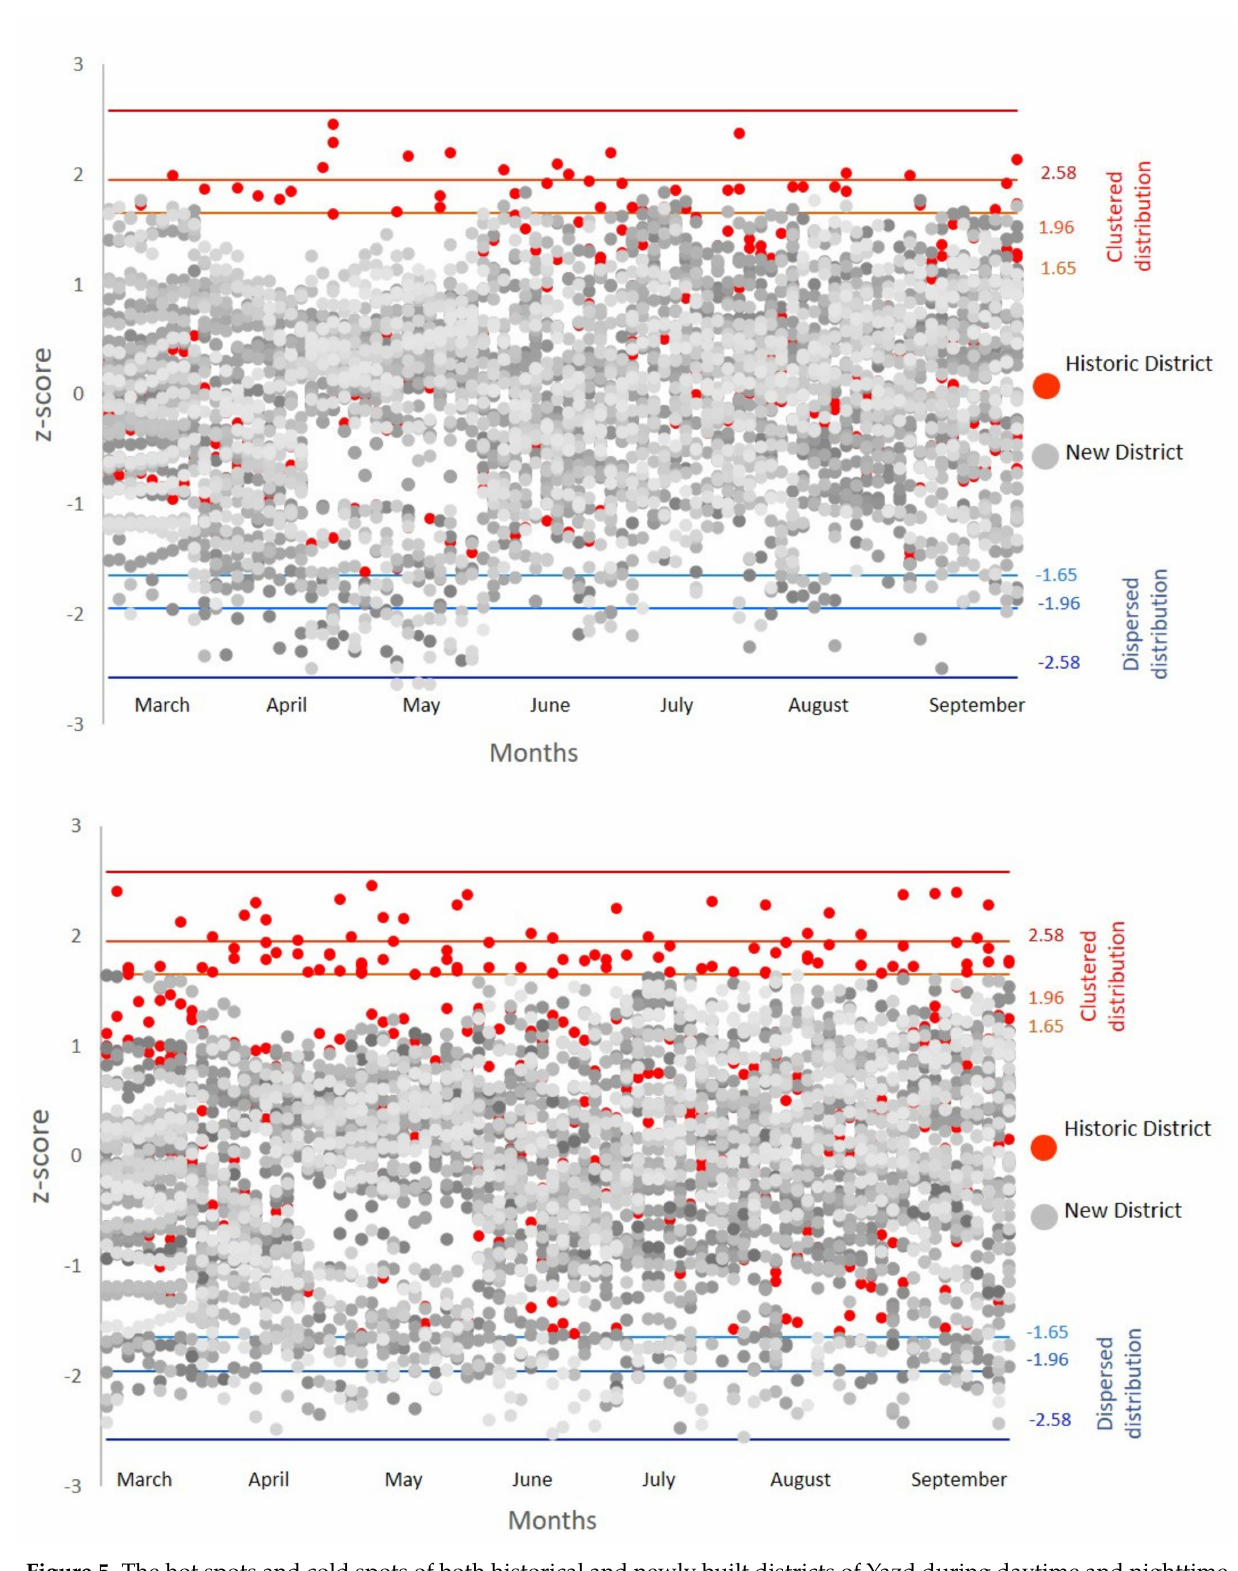
Figure 5. The hot spots and cold spots of both historical and newly built districts of Yazd during daytime and nighttime (from 25 March to 20 September